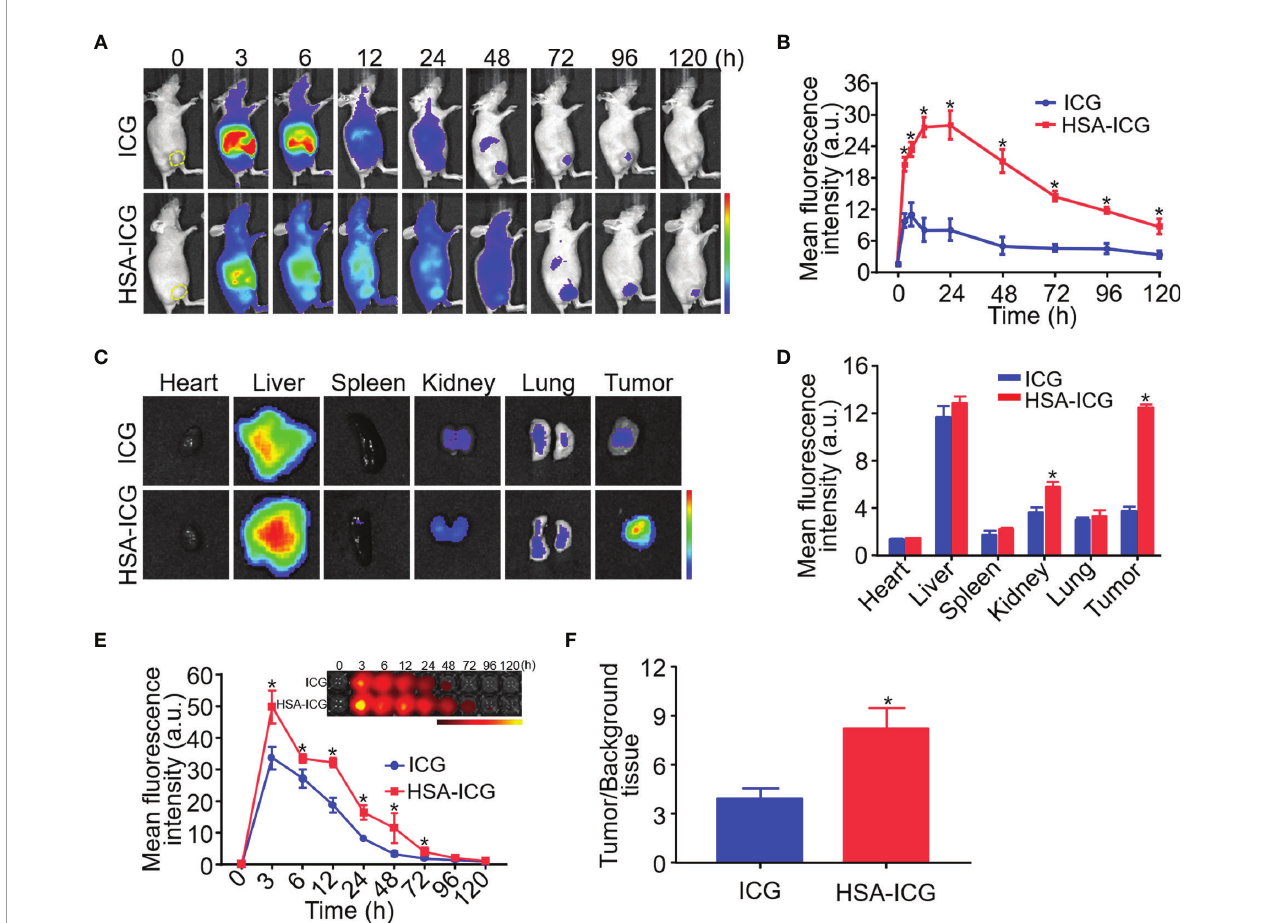
FIGURE 2 | In vivo and ex vivo fl uorescence imaging of HSA-ICG in MDA-MB-231 tumor-bearing mice. (A) In vivo fl uorescence images at indicated time points after intravenous injection of ICG or HSA-ICG (1 mg ICG per kg). Tumor tissue is delineated with a dashed line in the “ 0 ” images at far left. (B) Semi-quantitative analysis of in vivo fl uorescence intensity of tumors. (C) Fluorescence images from organs and tumors excised 24 h after the injection of ICG or HSA-ICG. (D) Semiquantitative analysis of fl uorescence signals from the samples in panel (C) . (E) Fluorescence images (inset) and semiquantitative analysis of fl uorescence in blood sampled at different times after intravenous injection of the probe. (F) Tumor-to-background tissue ratios obtained at 24 h after injection of HSA-ICG or ICG. Background tissue was from the upper limb. Each group n = 3, (unpaired Student ’ s t test, * P <